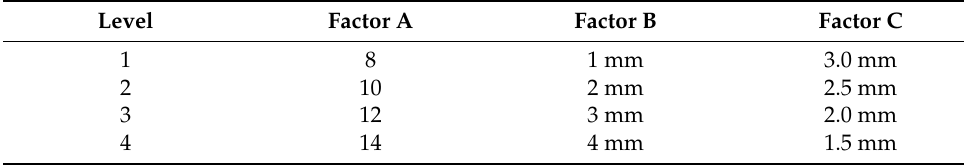
Table 4. Factors and levels of the orthogonal experiment.